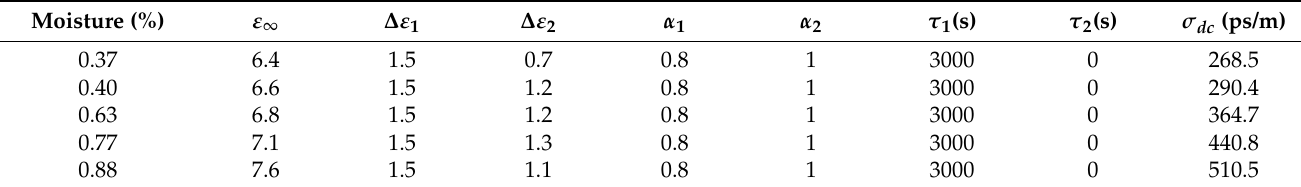
Table 3. Fitting parameters of semi-conductive